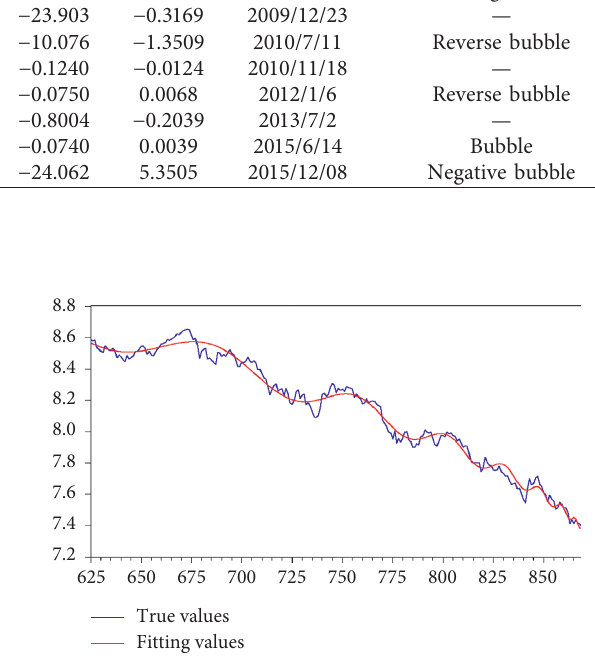
Figure 10: Fitting results from 2005/4 to 2007/10. Figure 11: Fitting results from 2007/10 to